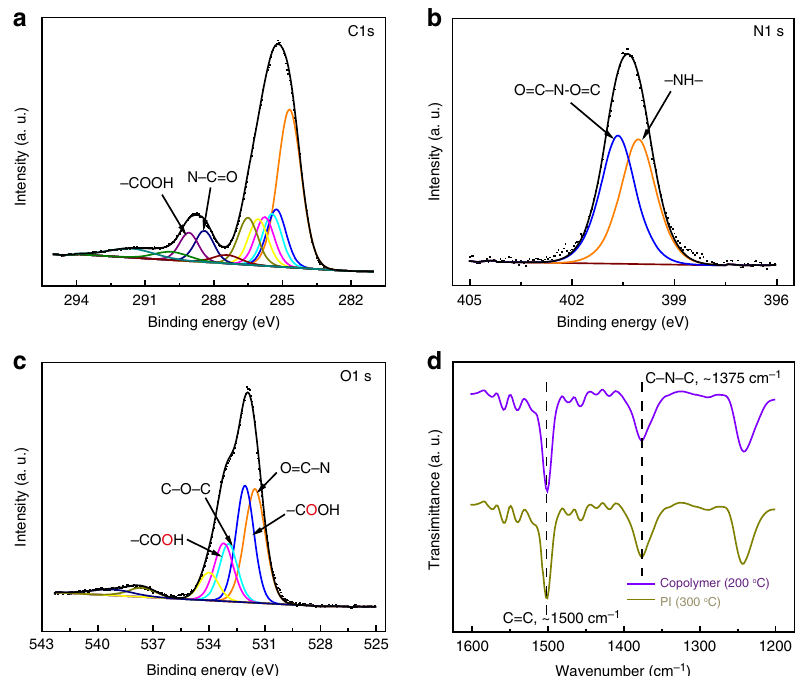
Fig. 2 XPS and ATR characterizations of copolymer and PI. XPS C ls ( a ), N ls ( b ), and O ls ( c ) spectra of the copolymer and ATR infrared spectroscopy of copolymer and PI ( d